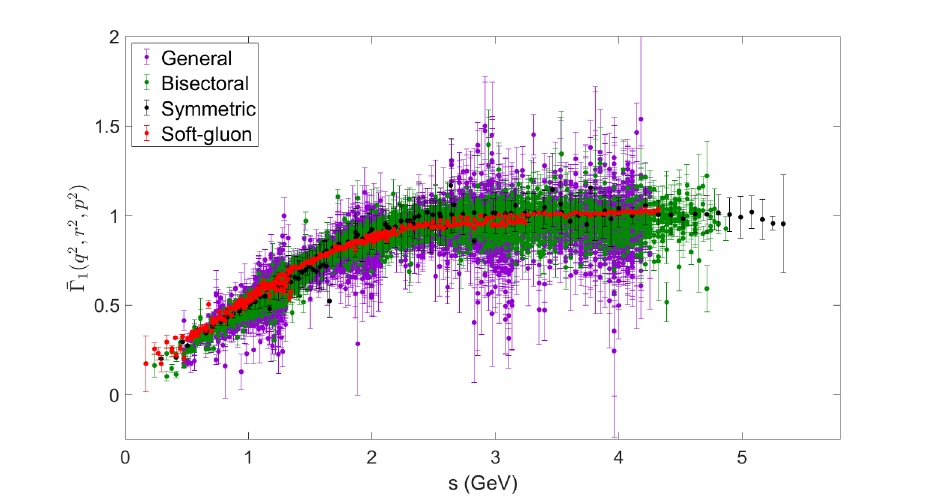
Figure 3. Illustration of the scaling of lattice data for the scalar form factor Γ 1 R ( q 2 , r 2 , p 2 ) in terms the symmetric combination of momenta s , for the di ff erent kinematics analyzed (in the legend). Each color represents the data for the four lattice setups in Tab. 1.The normalization point is µ = 4.3